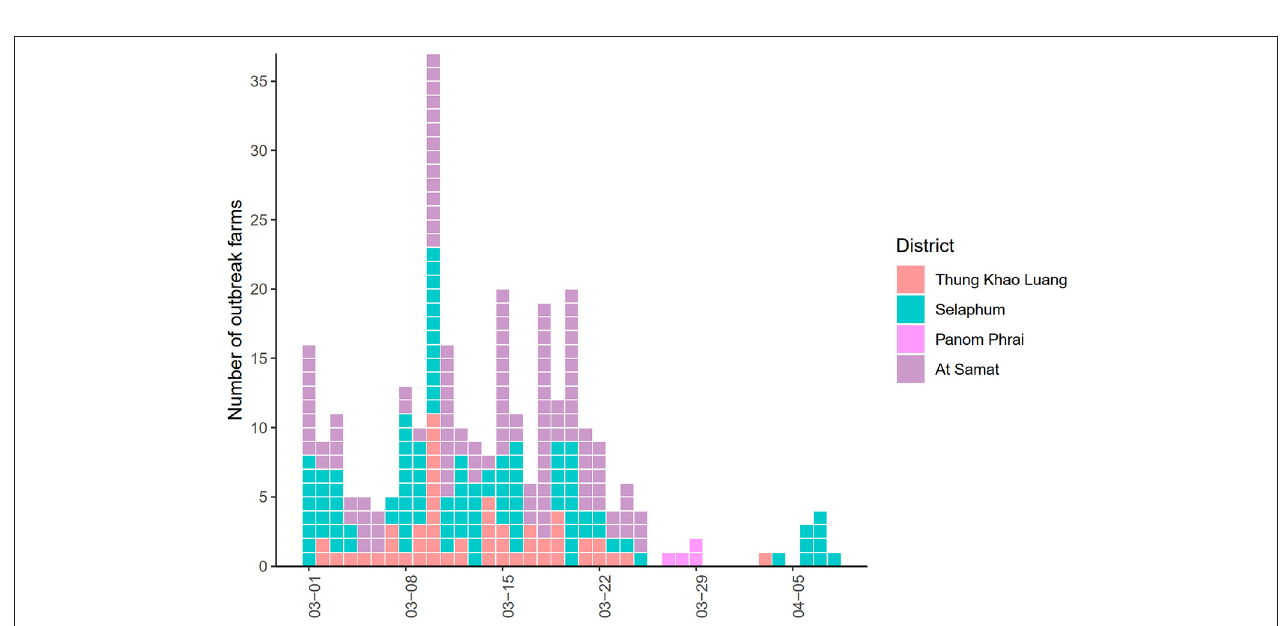
FIGURE 2 | Epidemic curve of lumpy skin disease outbreaks in cattle farms in four districts of Roi Et province, Thailand.